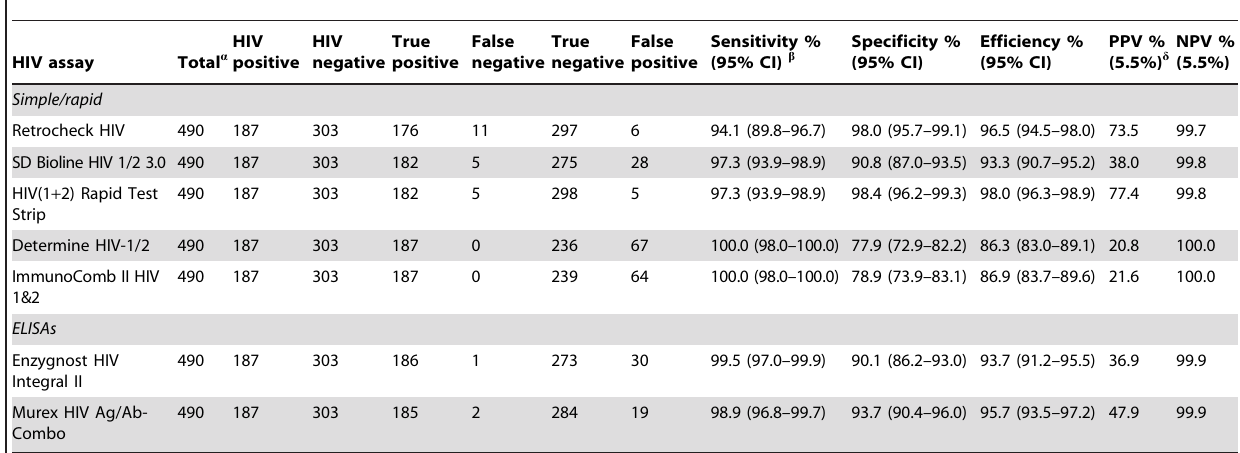
Table 3. Performance of HIV assays evaluated, indeterminate result samples included.